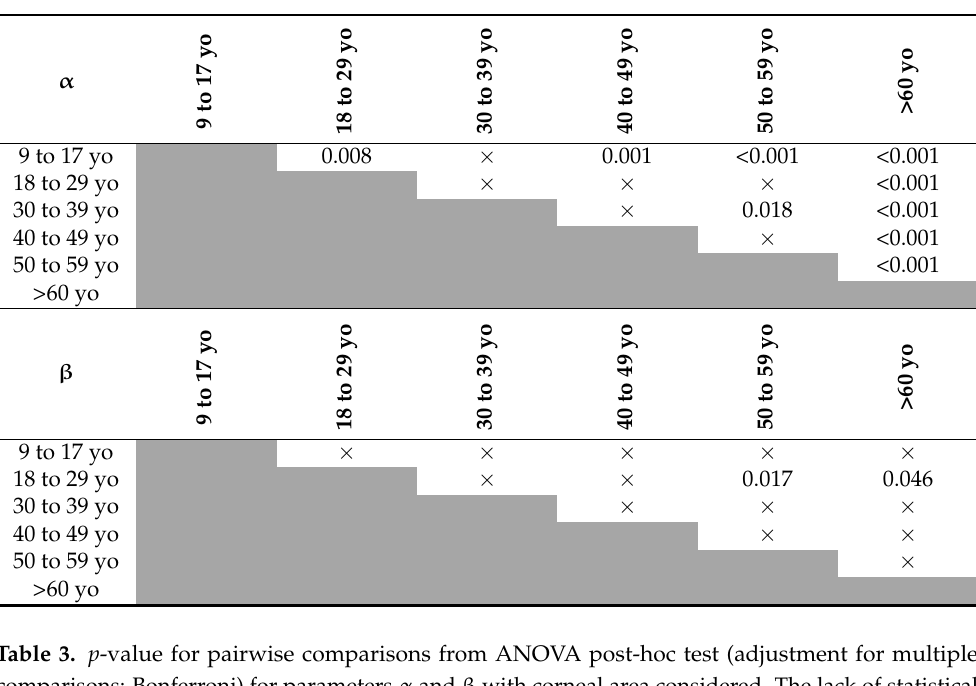
Table 2. p -value for pairwise comparisons from ANOVA post-hoc test (adjustment for multiple comparisons: Bonferroni) for parameters α and β with age. The lack of statistical significance is marked with a cross ( × ).